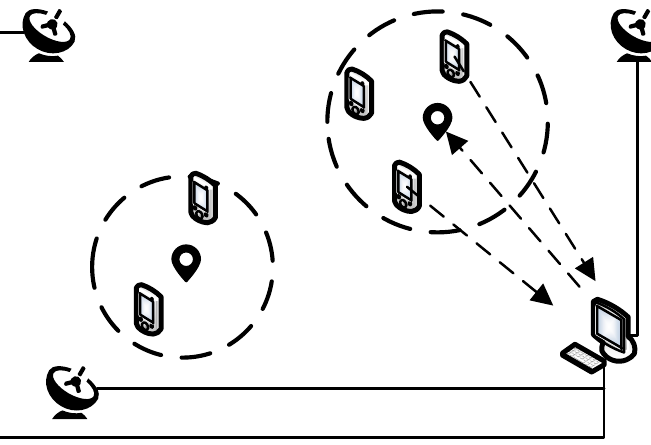
Figure 3. Illustration of the spatial clustering approach for the large-scale network RTK system.